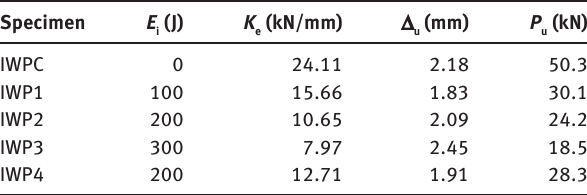
Figure 15: Failure mode of specimens after CAI tests.. Table 6: Test results of